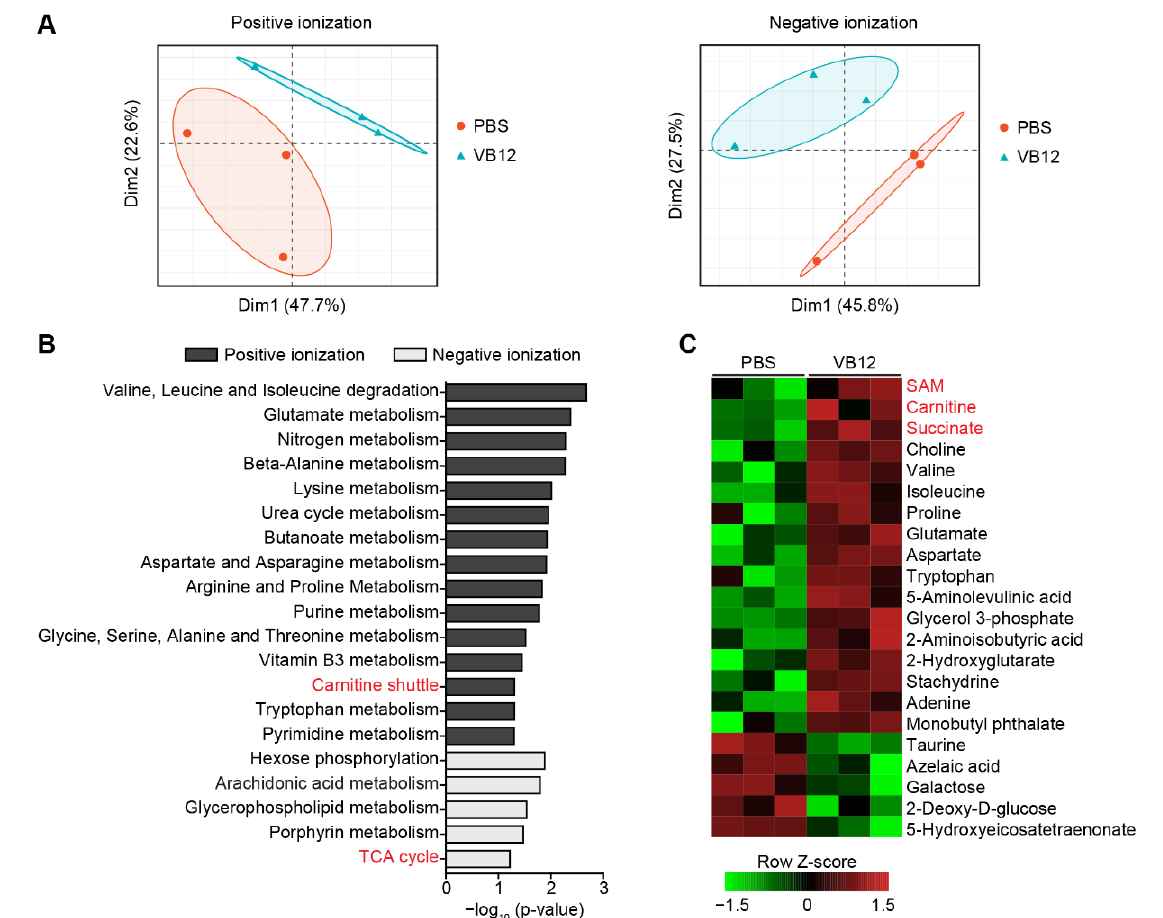
Figure 3. Metabolic programming of human iECs by VB12. ( A ) PCA plots of metabolite features identified by positive and negative ionization in human iECs cultured with VB12 or PBS for 2 weeks (n = 3 samples/group). ( B ) Significant metabolic pathway between VB12- and PBS-cultured iECs. ( C ) Heatmap showing differentially enriched metabolites. SAM, S -adenosylmethionine.